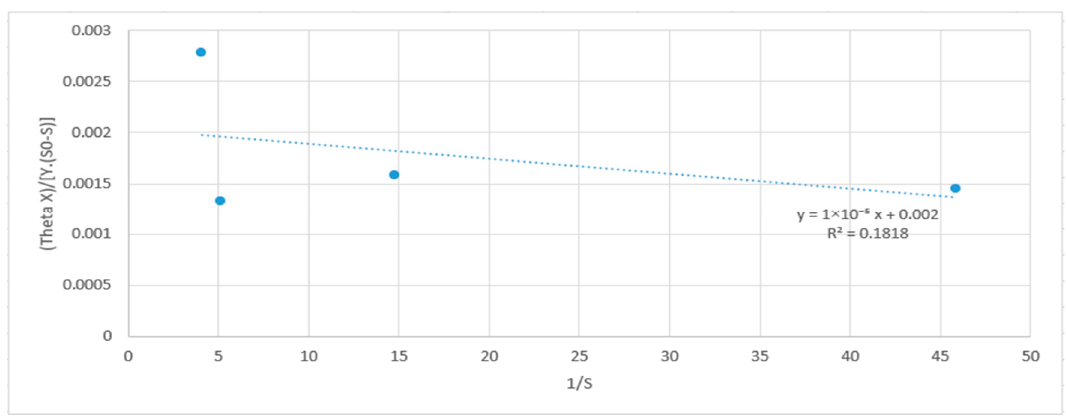
Figure 7. Graph of kinetic parameters (Y and k d ) of the LTP’s activated sludge system.